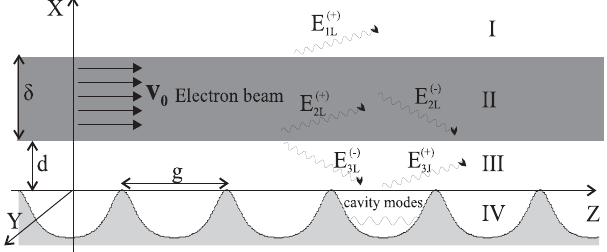
FIG. 1. The configuration of the Smith-Purcell FEL. The elec- tron beam moves at a distance d parallel to the grating surface in the z direction. The grooves, oriented in the y direction, repeat periodically with the grating period g . The electron beam thick- ness is (cid:1) . The grating surface is at x (cid:5) 0